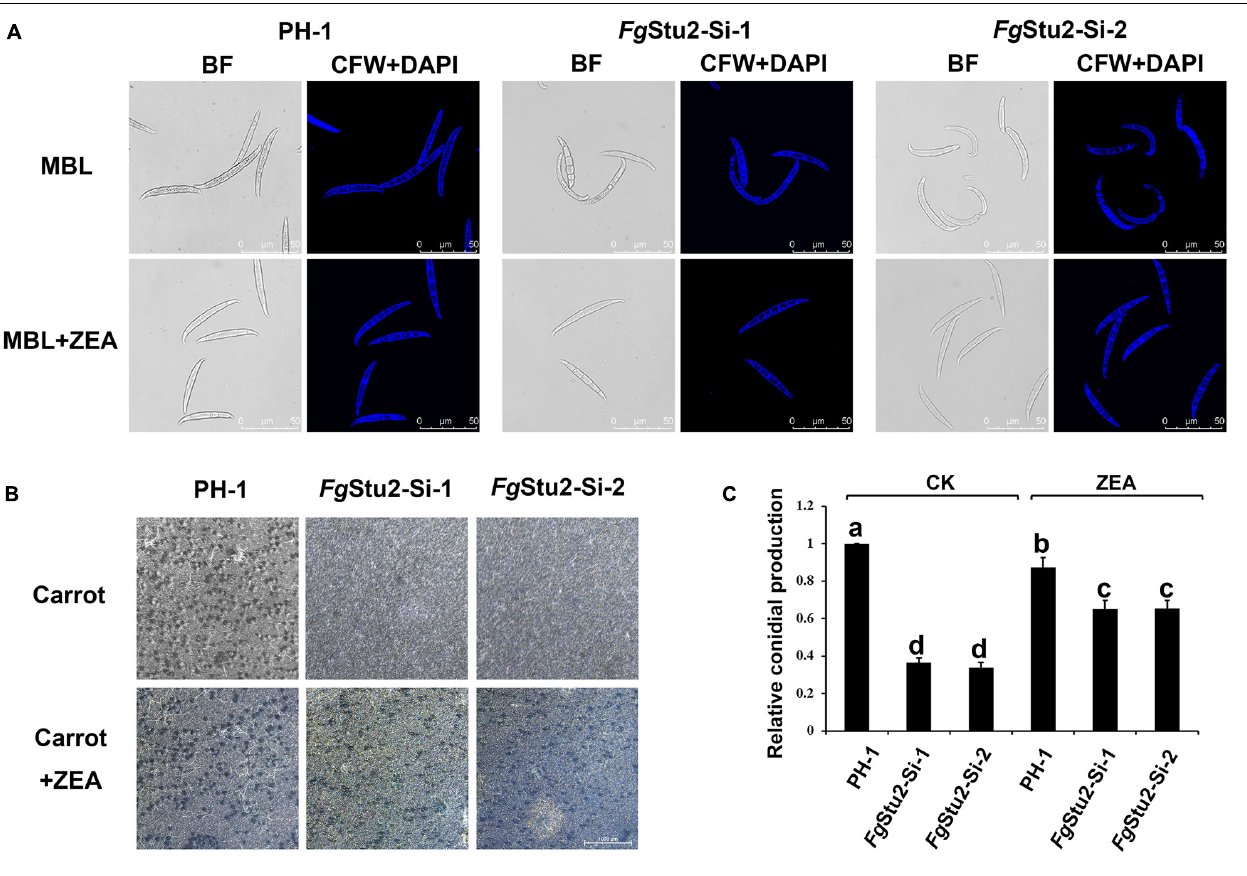
FIGURE 7 | Roles of Fg Stu2 gene in sexual and asexual reproduction. (A) Conidial morphology of wild-type strain PH-1, Fg Stu2-Si mutants. The conidia of all strains were harvested after 3-days cultivation in mung bean liquid (MBL) medium with or without 30 µ M zearalenone (ZEA) at 25 ◦ C. Fresh conidia were first stained with calcofluor white (CFW) and 4’,6-diamidino-2-phenylindole (DAPI) and then photographed using a confocal laser-scanning microscope. Bar = 50 µ m. (B) Ability of perithecia production of wild-type strain PH-1, Fg Stu2-Si-1, Fg Stu2-Si-2. Inoculate fresh mycelia of each stain to carrot medium plates with or without 30 Mm ZEA and keep it at 25 ◦ C incubator until the plates are full of mycelia. Then clean out the mycelia and add 2.5% Tween 60 solution to the plates. Keep the plates into 25 ◦ C incubator with near-UV light for about one or two weeks until the black perithecia were appeared and then photograph the plates by stereomicroscope. Bar = 1000 µ m. (C) Numbers of conidial production of wild-type strain PH-1, Fg Stu2-Si-1, Fg Stu2-Si-2. Conidial production was measured by hemacytometer after three days incubation in mung bean liquid (MBL) medium with or without 30 µ M ZEA. Means of the column with the same letter are not significantly different ( P <